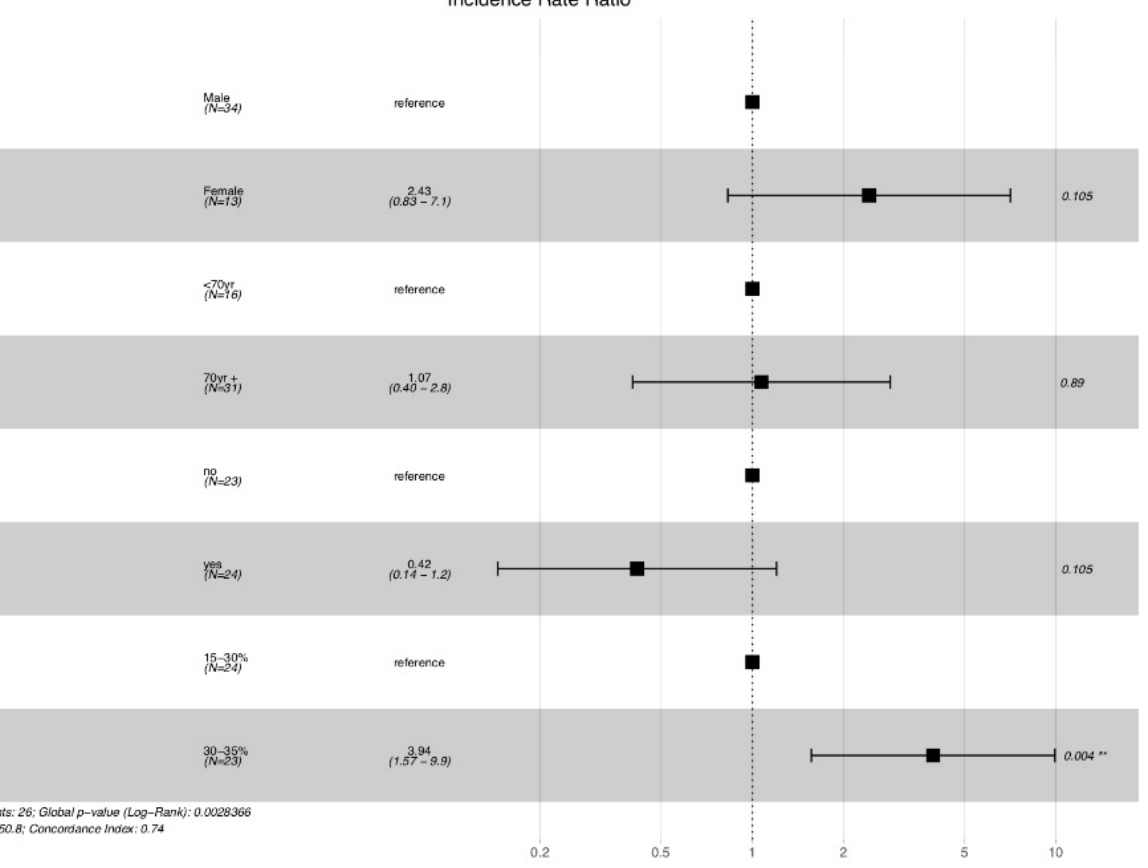
Figure 2. Multivariate stepwise model for the cumulative probability of achieving LVEF above 35%. CKD: Chronic kidney disease; LVEF: Left ventricular ejection fraction. ** Statistically significant. During the entire follow-up, there was no evidence of malignant ventricular arrhythmias (symptomatic ventricular tachycardia or ventricular fibrillation) or sudden cardiac death, considering clinical and electrocardiographic data.